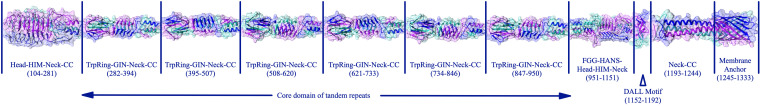
The complete assembly of the BatA structure. The complete structure of BatA is shown as cartoons with transplant surfaces. The position of each domain within the amino acid sequence of the protein is given at the bottom of each domain.